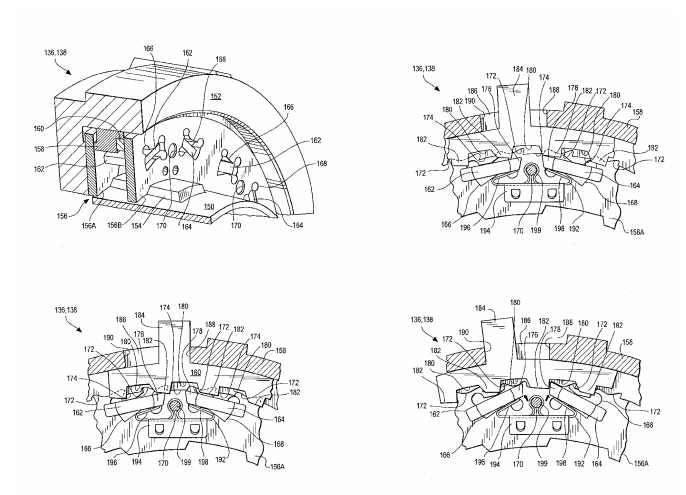
Figure 15. Views of possible embodiment of a multimodal clutch